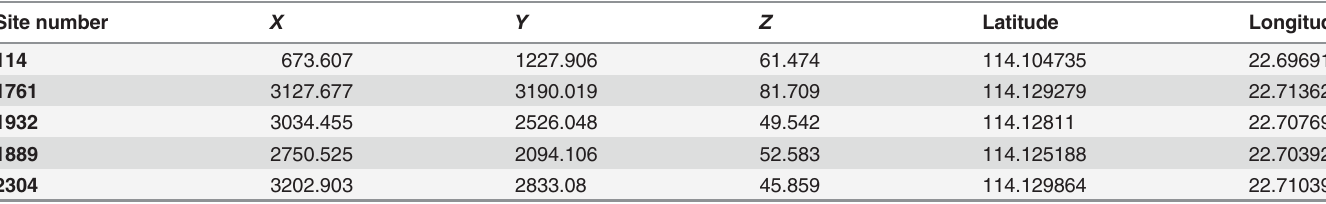
Table 3. The coordinates of atmospheric environmental monitoring sites in the 3 rd season. Site